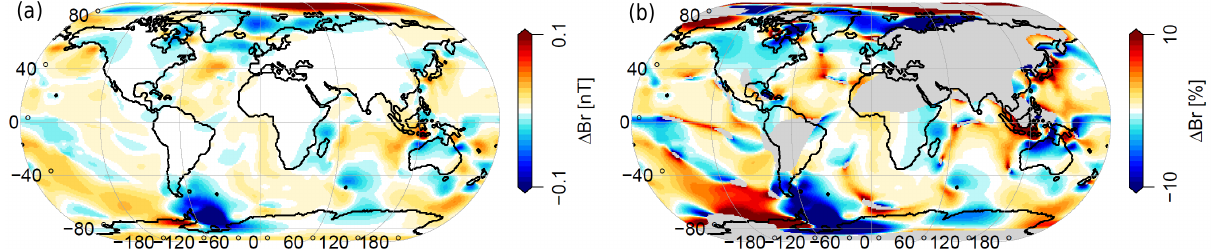
Figure 2. Differences in radial tidal magnetic field at satellite height. HAMTIDE minus TPXO amplitudes, i.e., two assimilative models.